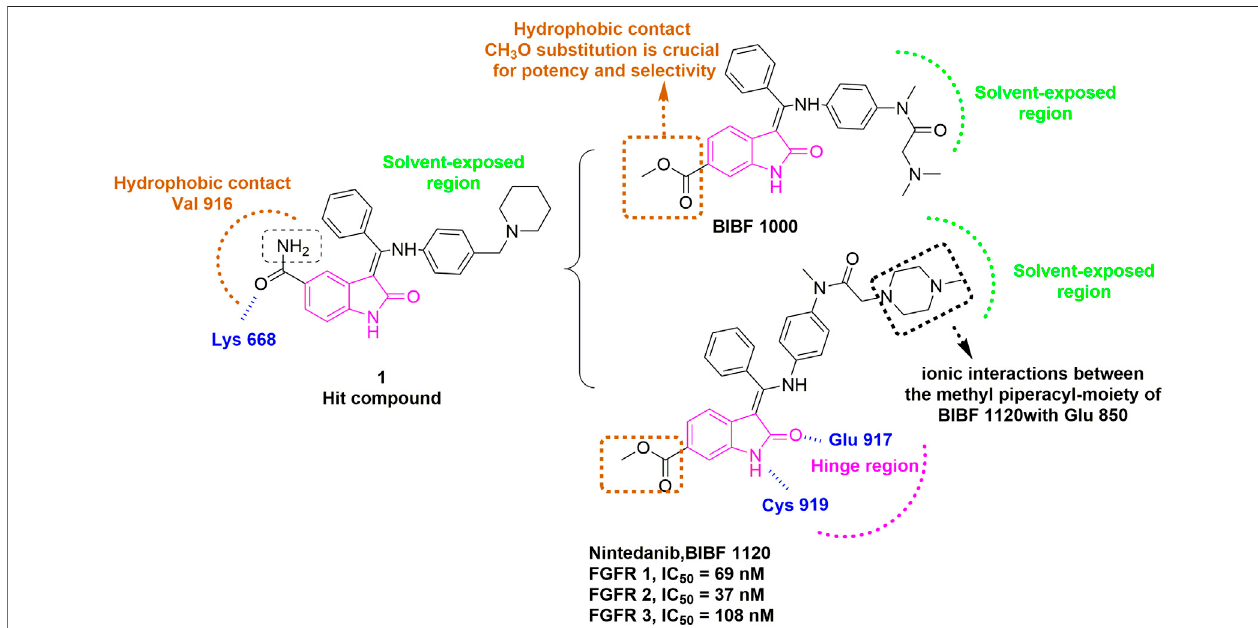
FIGURE5| DiscoveryofBIBF1120.H-bondsareoutlinedasbluehashedlines.Themethyl-piperazinylmoietyisinvolvedintheionicinteractionwiththesidechains ofGlu850(Black).Hydrophobicinteractionisoutlinedbyhashedbrownrectangle.Solvent-exposedregionishighlightedusinggreenrectangle.Hingeregionisindicated by pink